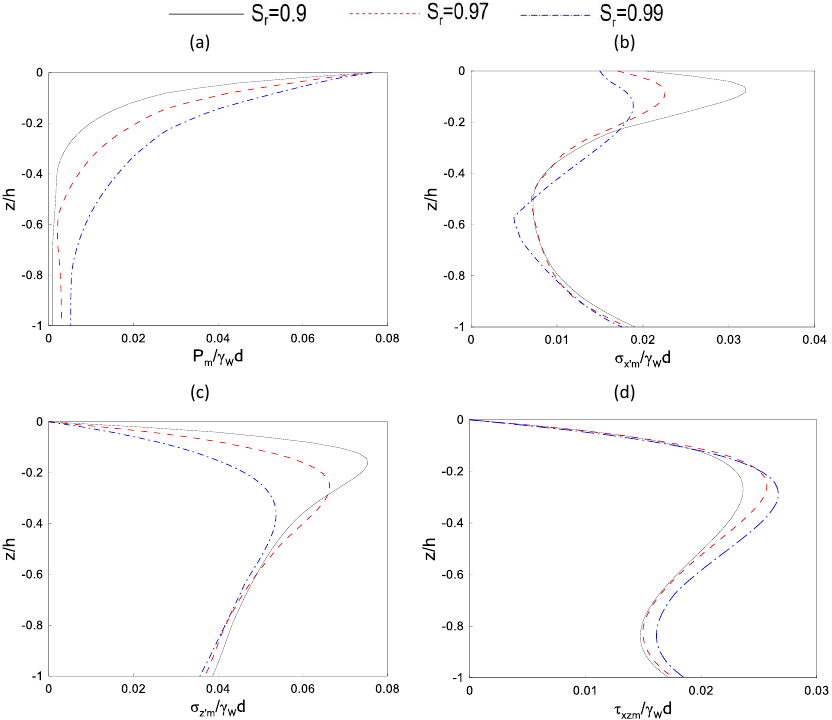
Figure 24. Distribution of the maximum soil response under the random wave with various degree of saturation. ( a ) pore-water pressures ( p m / γ w d ); ( b ) horizontal effective normal stress ( σ (cid:48) xm / γ w d ); ( c ) vertical effective normal stress ( σ (cid:48) zm / γ w d ); and ( d ) shear stress ( τ xzm / γ w d